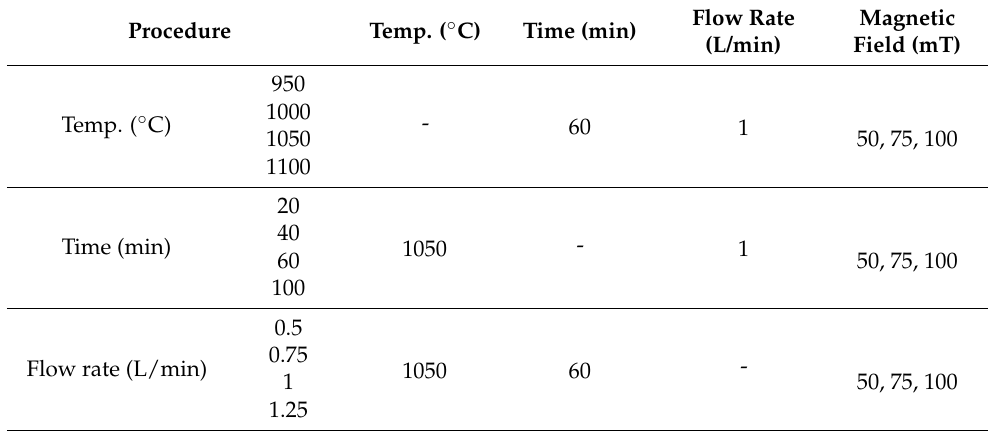
Table 2. Experimental conditions of oxidation and magnetic